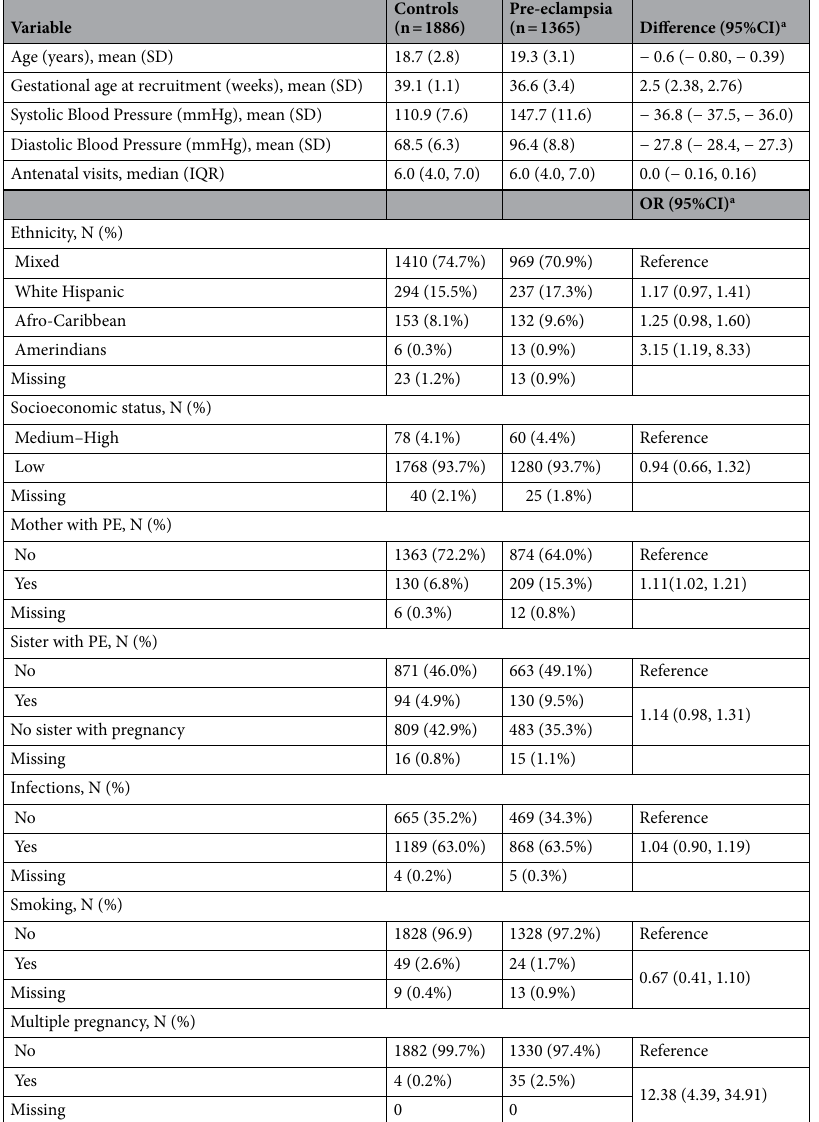
Table 1. Clinical and demographic characteristics of GenPE participants. PE, pre-eclampsia; IQR, interquartile range. a Mean differences calculated with t-test with unequal variances for continuous variables. Difference in medians calculated with median regression. For categorical variables, unadjusted ORs were calculated through logistic regression with controls as reference group. Infections: vaginosis, urinary tract infections, sexual transmitted diseases and